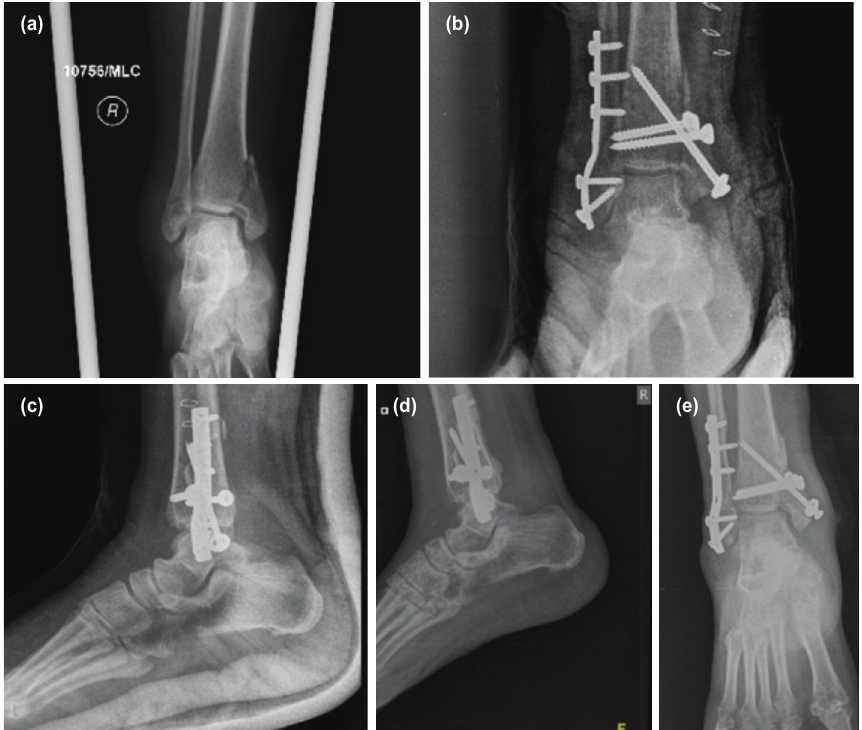
(a) Pre-operative radiograph of a 41-year-old female with bimalleolar ankle fracture who was operated. (b, c) Shows the Fig. 3: immediate post-operative radiograph and (d, e) shows medial malleolus non-union at the end of one year